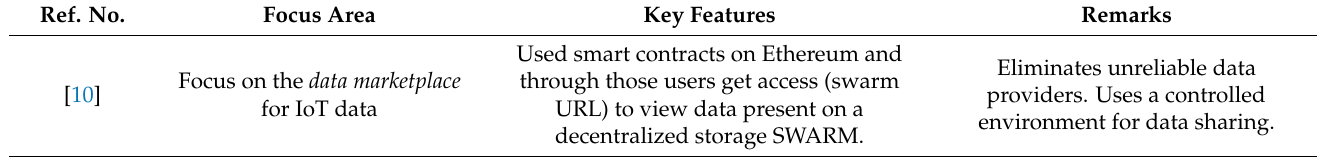
Table 1. Summary and analysis of related research works on blockchain and